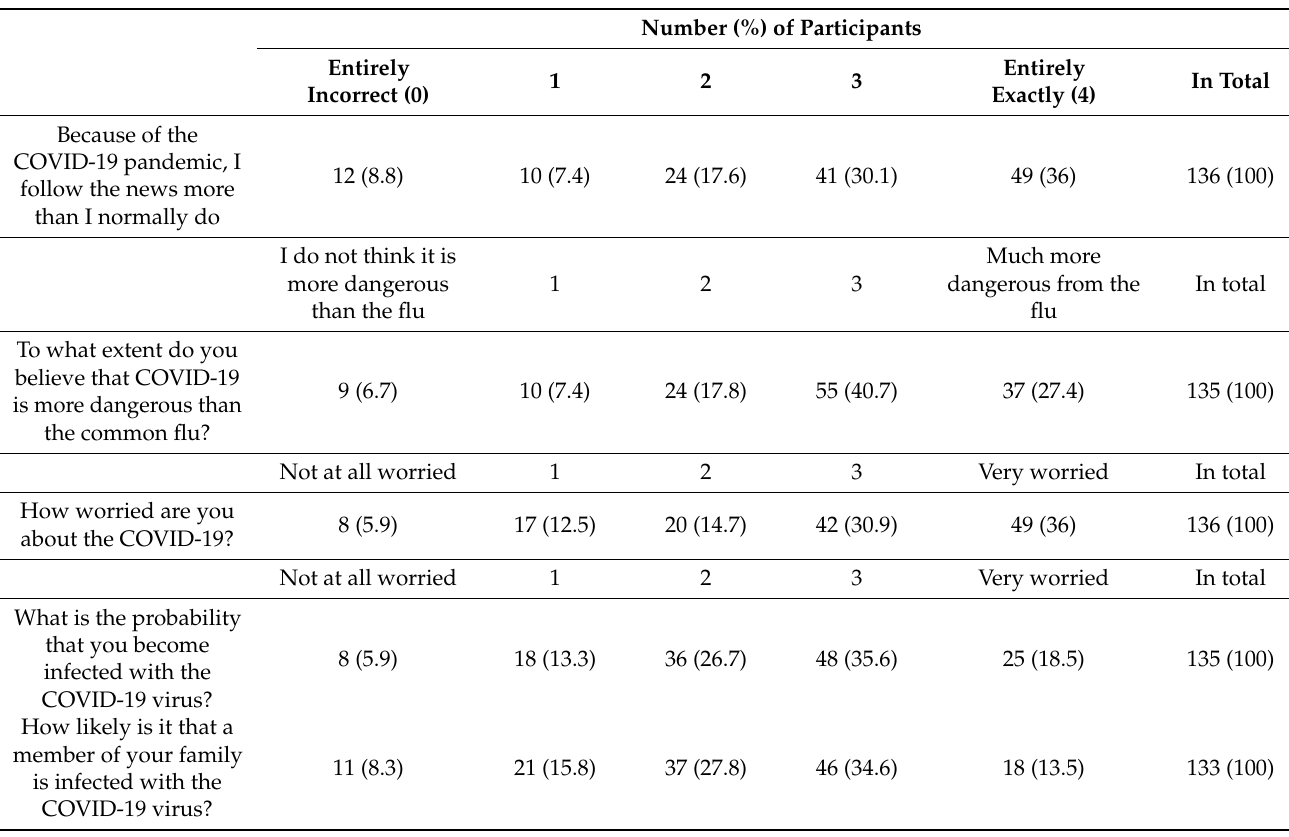
Table 4. Self-assessment of behavior during the COVID-19 pandemic.